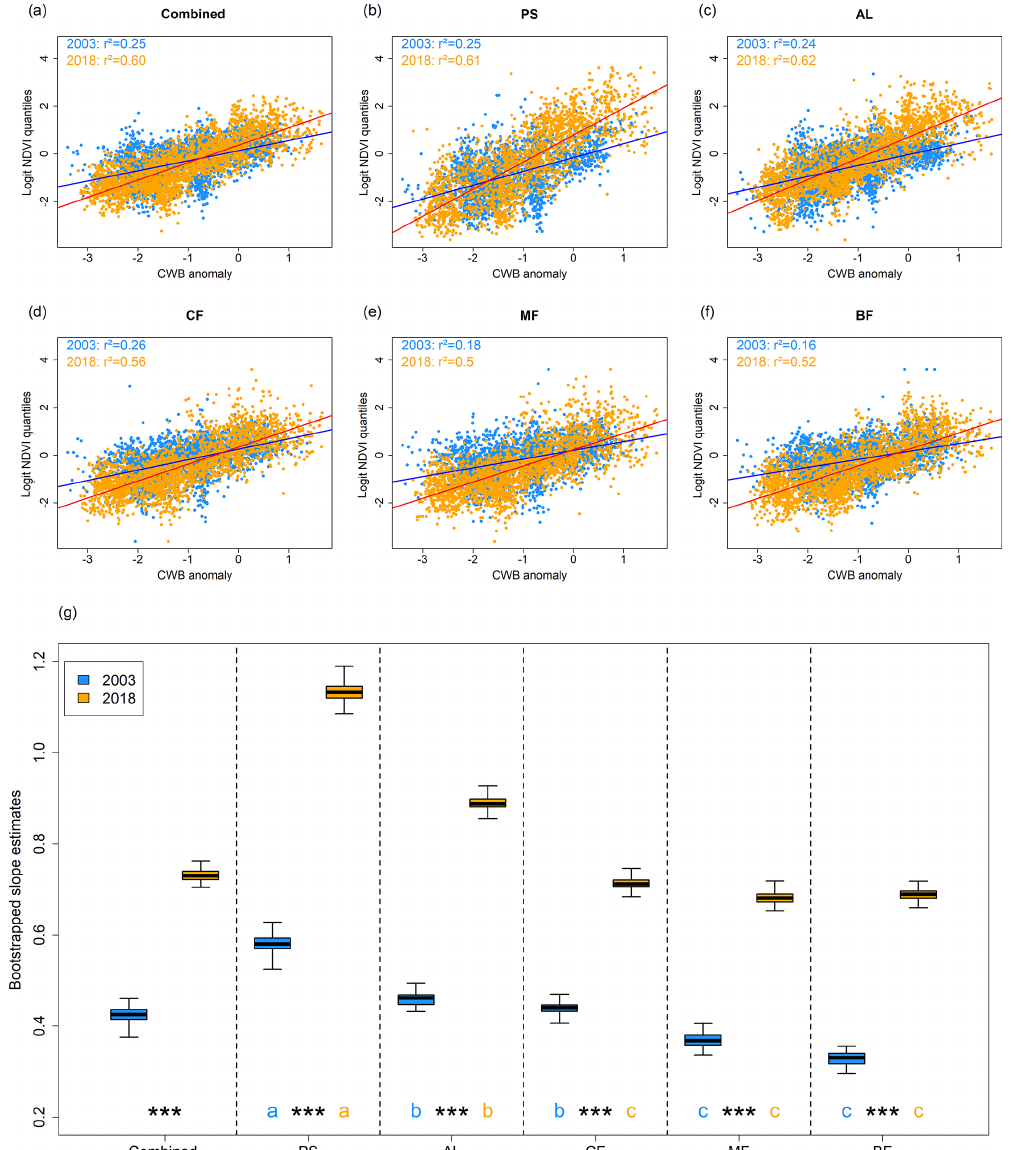
Figure 7. (a–f) Scatter plots depicting the relationship between average logit-transformed NDVI quantiles and mean CWB in 2003 (blue) and 2018 (orange) for pastures (b) , arable land (c) , coniferous forests (d) , mixed forest (e) , broadleaved forest (f) , and a combination of those (a) . Blue lines depict the regression line for 2003 and red lines for 2018. (g) Bootstrapped regression slope estimates for the five different land cover classes as well as their combination. Minor case letters refer to group assignment of land cover classes according to the overlap of 99.9% confidence intervals of bootstrapped slopes in 2003 (blue) and 2018 (orange). Significance stars ( ∗∗∗ ) indicate no overlap between 99.9% confidence intervals of 2003 and 2018 for the respective land cover class. PS: pastures; AL: arable land; CF: coniferous forest; MF: mixed forest; BF: broadleaved forest. Complementary results for MODIS EVI are shown in Fig.